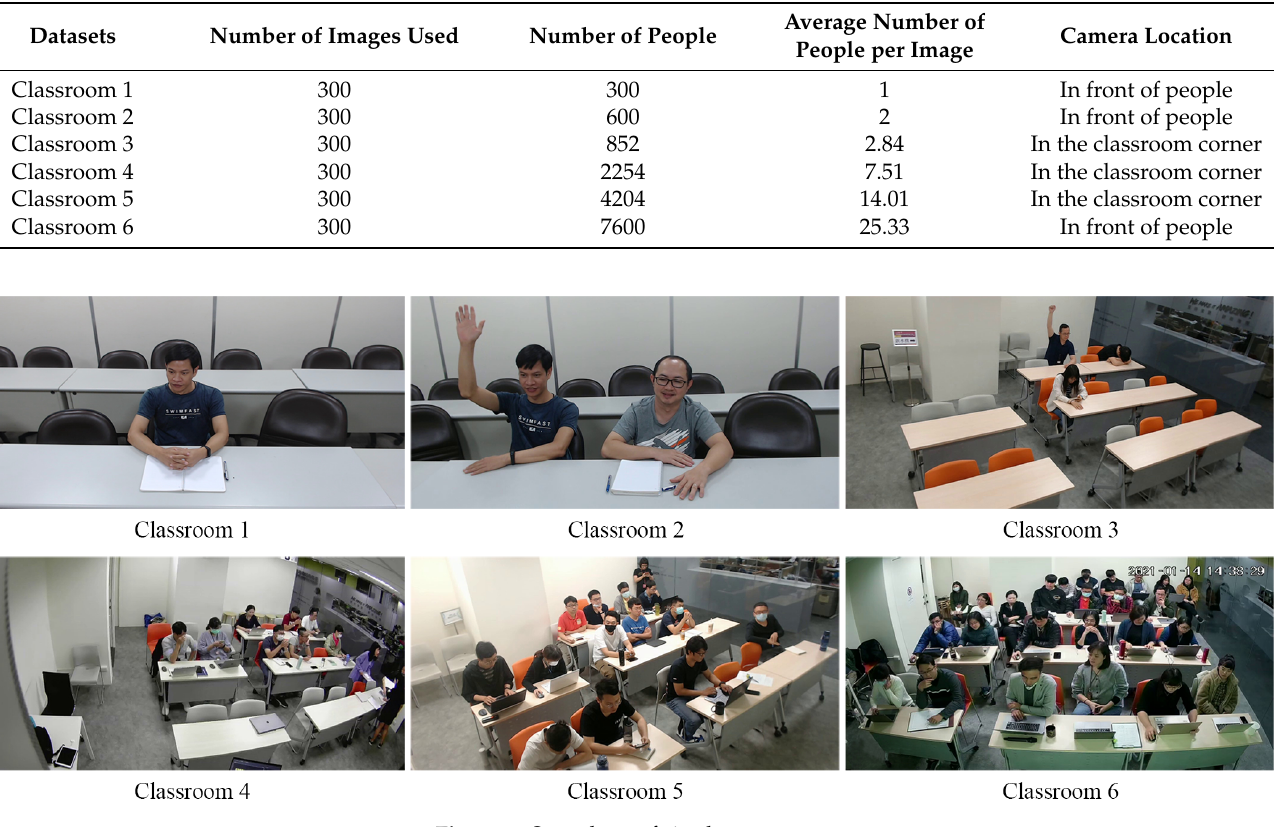
Figure 9. Snapshots of six